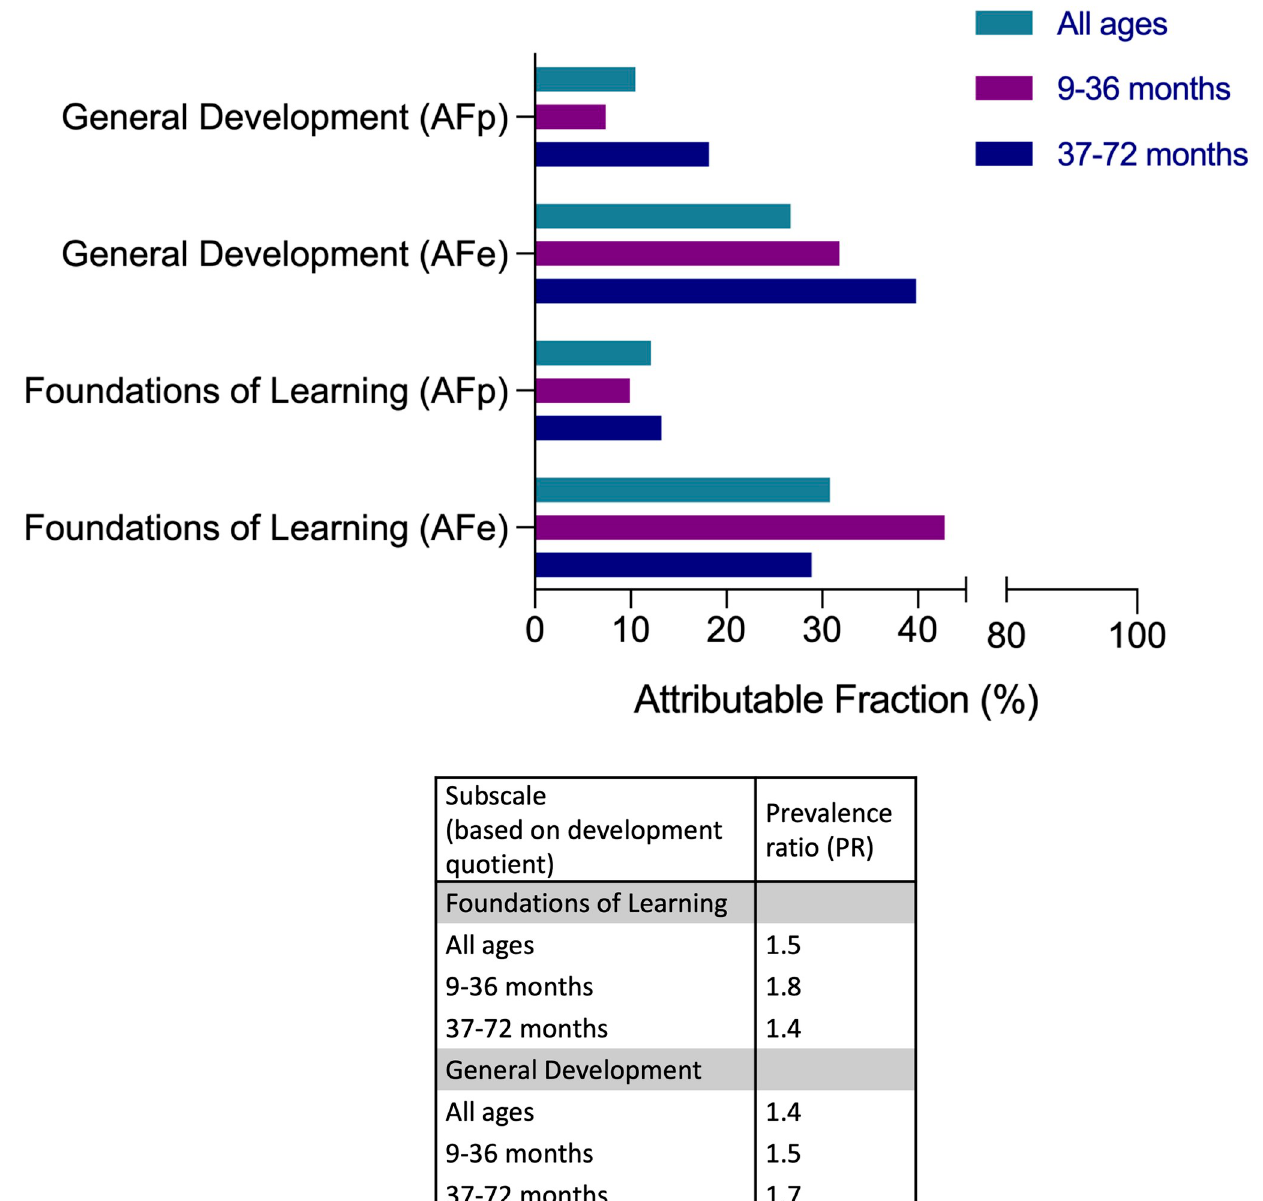
Fig 3. Estimated proportion of poor cognitive performance (based on development quotient) attributable to S . haematobium infection. AFe = Attributable fraction in the infected population, AFp = attributable fraction in the total population. Attributable fractions were estimated for indices with PR >